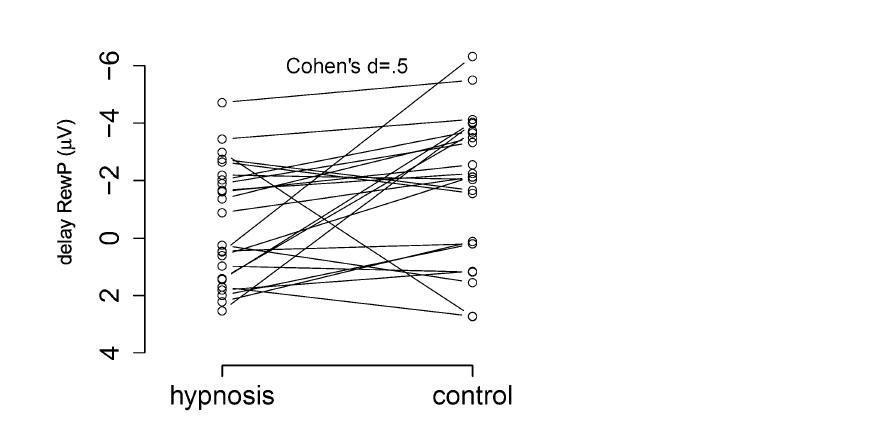
Figure 8. Delay reward positivity for each participant in both the hypnosis and control condition, illustrating the significant condition effect with Cohen’s d effect size.